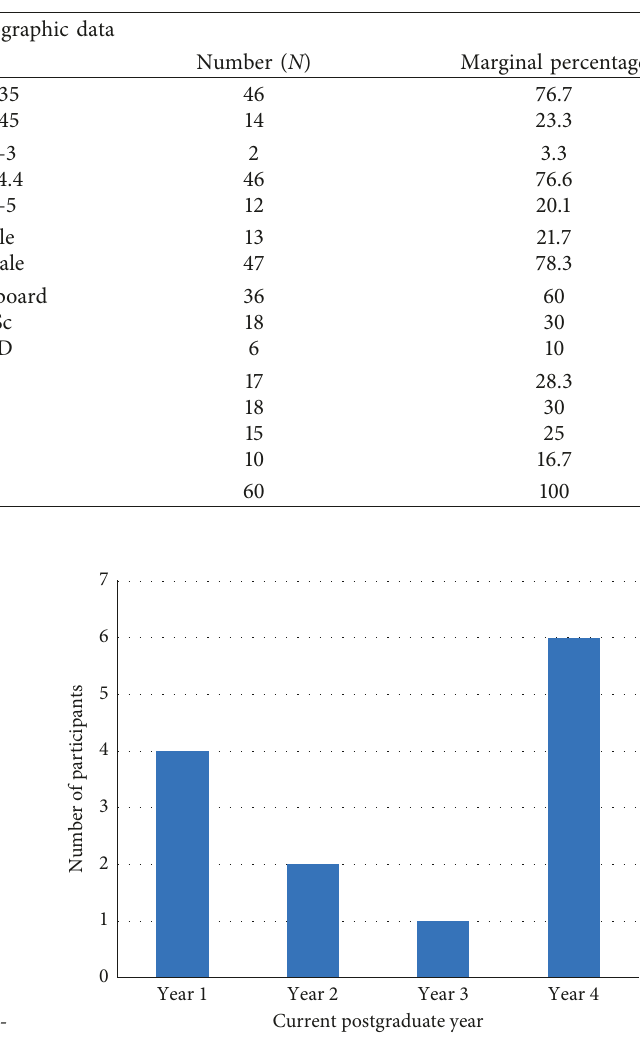
Figure 2: Level of anxiety during clinical diagnosis with respect to postgraduate current